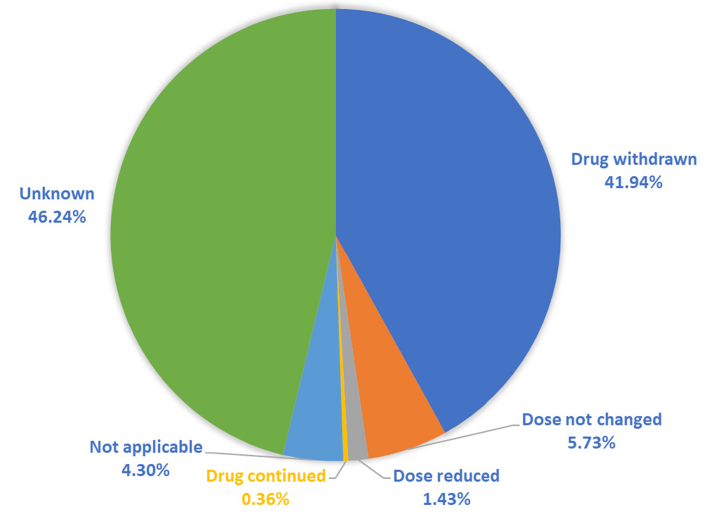
Figure 2. Actions taken for antimicrobial-related ADEs.